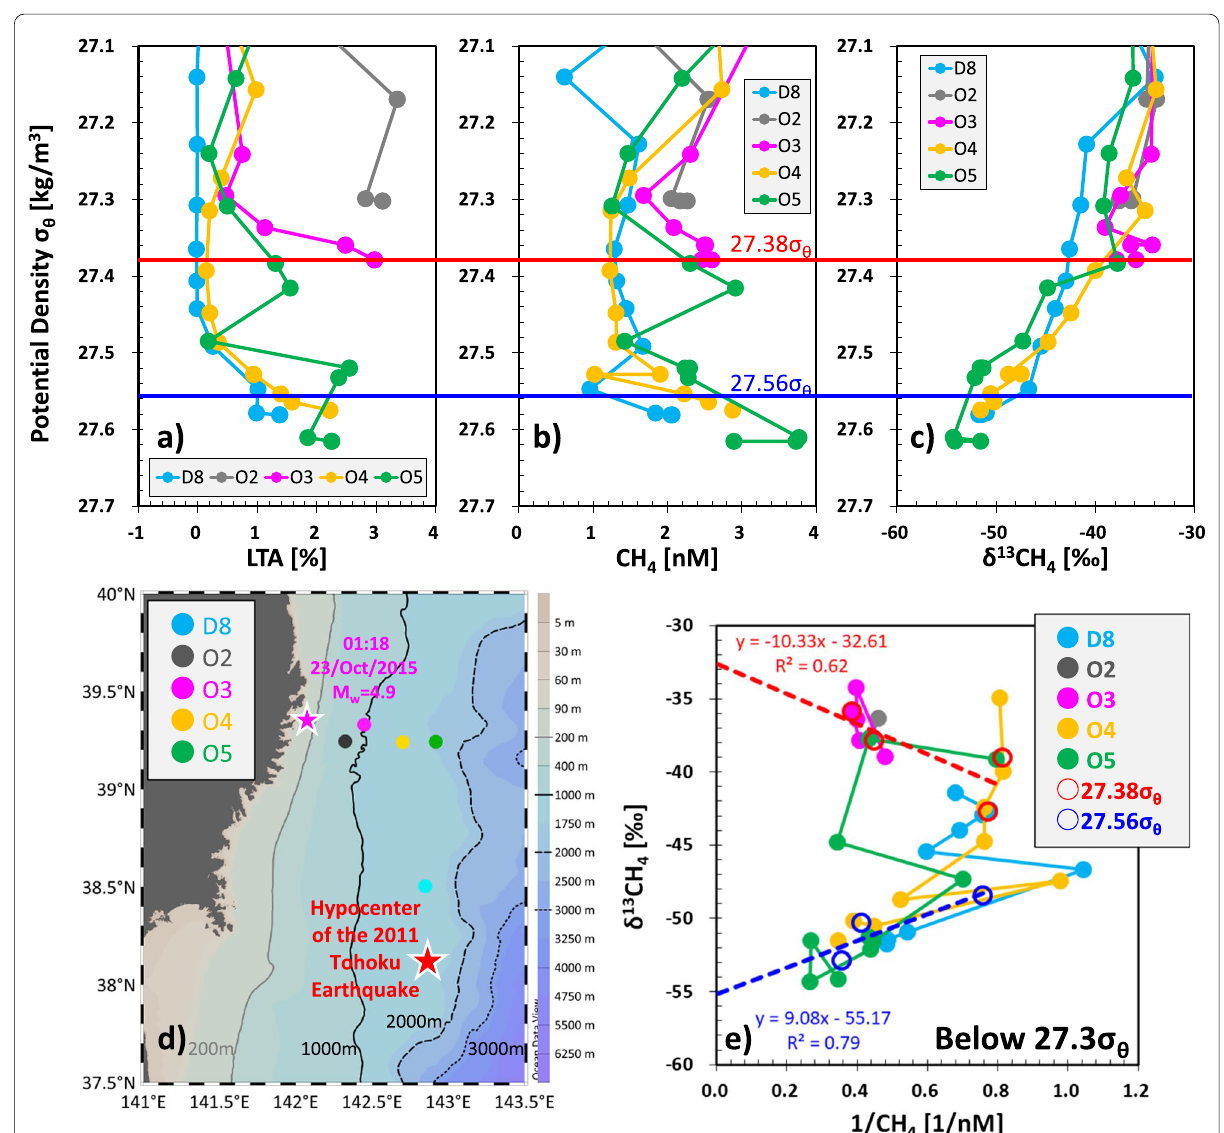
Fig. 9 a – c Vertical profiles of LTA ( a ), methane (CH 4 ), b and stable carbon isotope ratio of methane (δ 13 CH 4 ) as functions of potential density (σ θ ) at five sampling stations (D8, O2, O3, O4, and O5) during cruise KS-15–15. Lines show the studied isopycnal surfaces (27.38σ θ : red; 27.56σ θ : blue). d Location map and bathymetry of sampling stations during cruise KS-15-15, with the hypocenter of the 2011 Tohoku Earthquake and the earthquake on October 23, 2015 (Mw 4.9), shown as a red star and a pink star. Bathymetric contours show 200 m depth (solid gray line), 1000 m depth (solid = black line), 2000 m depth (dashed black line), and 3000 m depth (dotted black line). The color bar shows the depth of bathymetry. e Keeling plot of concentrations of CH 4 and δ 13 CH 4 at five sampling stations (D8, O2, O3, O4, and O5) during cruise KS-15-15. Open circles denote data for the studied isopycnal surfaces (27.38σ θ : red; 27.56σ θ : blue), and dashed red and dashed blue lines show the respective linear regression